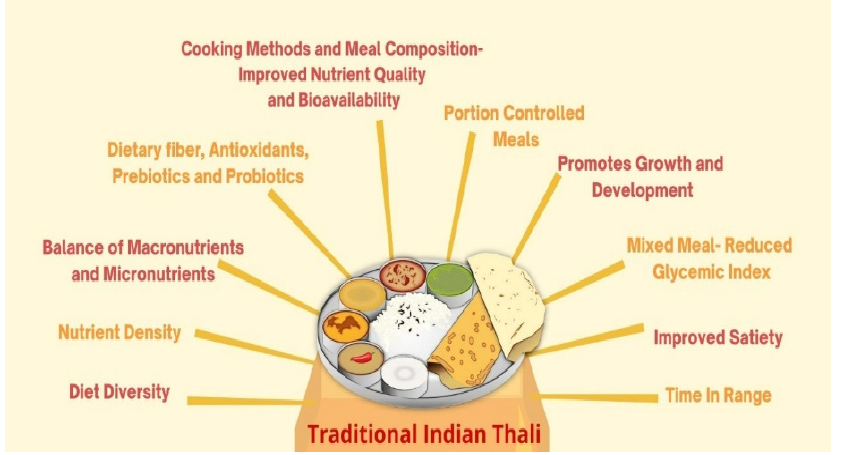
Figure 2. Benefits of the traditional Indian Thali in meeting nutritional requirements and achieving glycemic control in people with diabetes (PwD). Supplementary Materials: The following are available online at www.mdpi.com/xxx/s1, Table S1: Common Indian preparations with grains that increase nutritive value and lower glycemic index (GI), Table S2: Some common Indian preparations with pulses with high nutritive value and low glycemic index (GI), Table S3: Some common Indian recipes with cereal pulse combinations, Table S4: Some examples of commonly consumed beverages of India, Table S5: Some examples of festive foods of India.